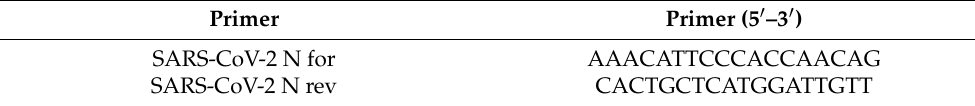
Table 1. Primers used for